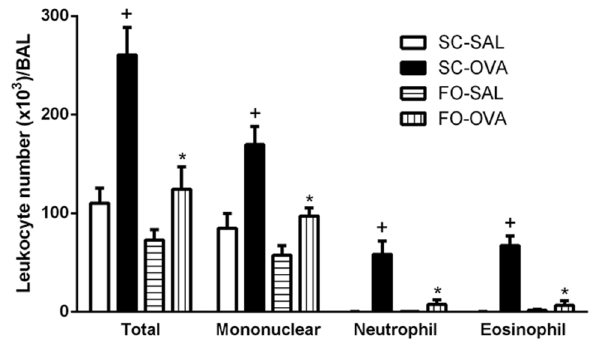
Figure 1. Effect of FO intake on allergen-evoked leukocyte infiltration in BAL fluid from A/J mice. Sensitized, saline- challenged (SC-SAL); sensitized, ovalbumin-challenged (SC- OVA); sensitized, saline-challenged with fish oil (FO-SAL) and sensitized, ovalbumin-challenged with fish-oil (FO-OVA). The analyses were performed 24 hours after the last challenge. In the signaled cases, P <0.05 compared with the SC-SAL group (+) and the SC-OVA group (*) (one-way ANOVA and post-hoc Holm-Sidak test). Values are the means ± S.E.M. and are representative of 1 experiment (n=5 per group).